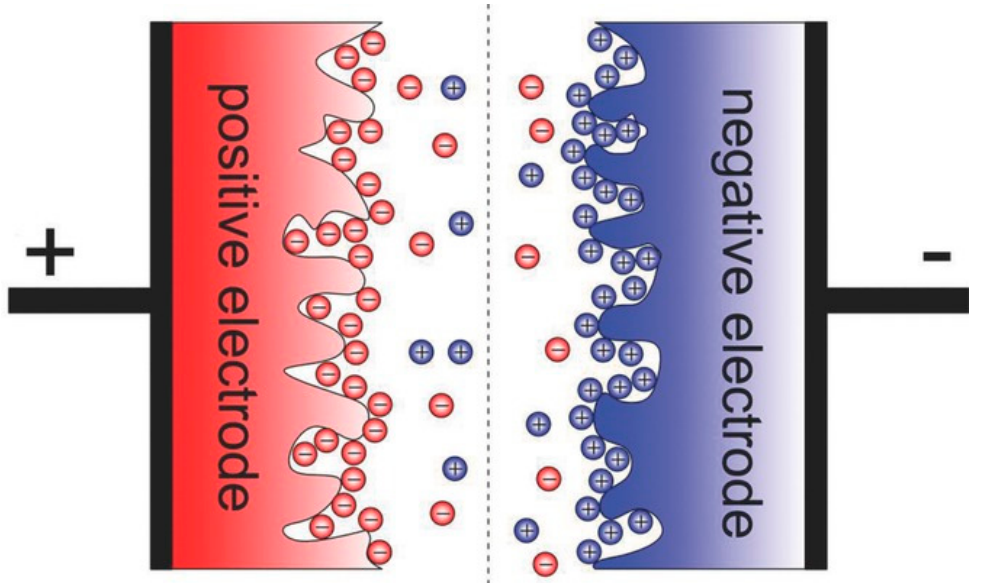
Figure 4. Representation of the charge storage mechanism in an electrical double-layer capacitor with porous electrodes [19].